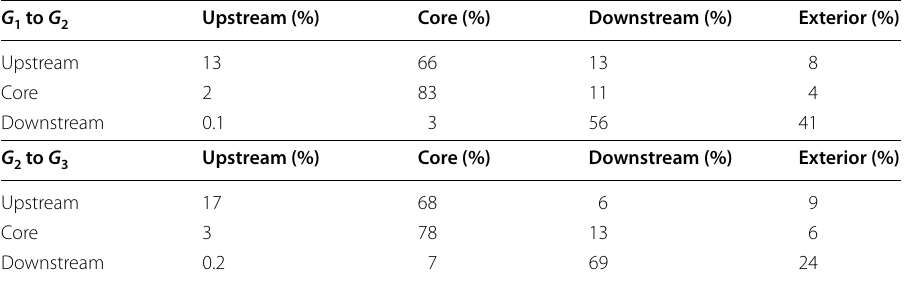
Table 5 Movement of channels across upstream, core and downstream communities between the networks corresponding to different time periods G 1 to G 2